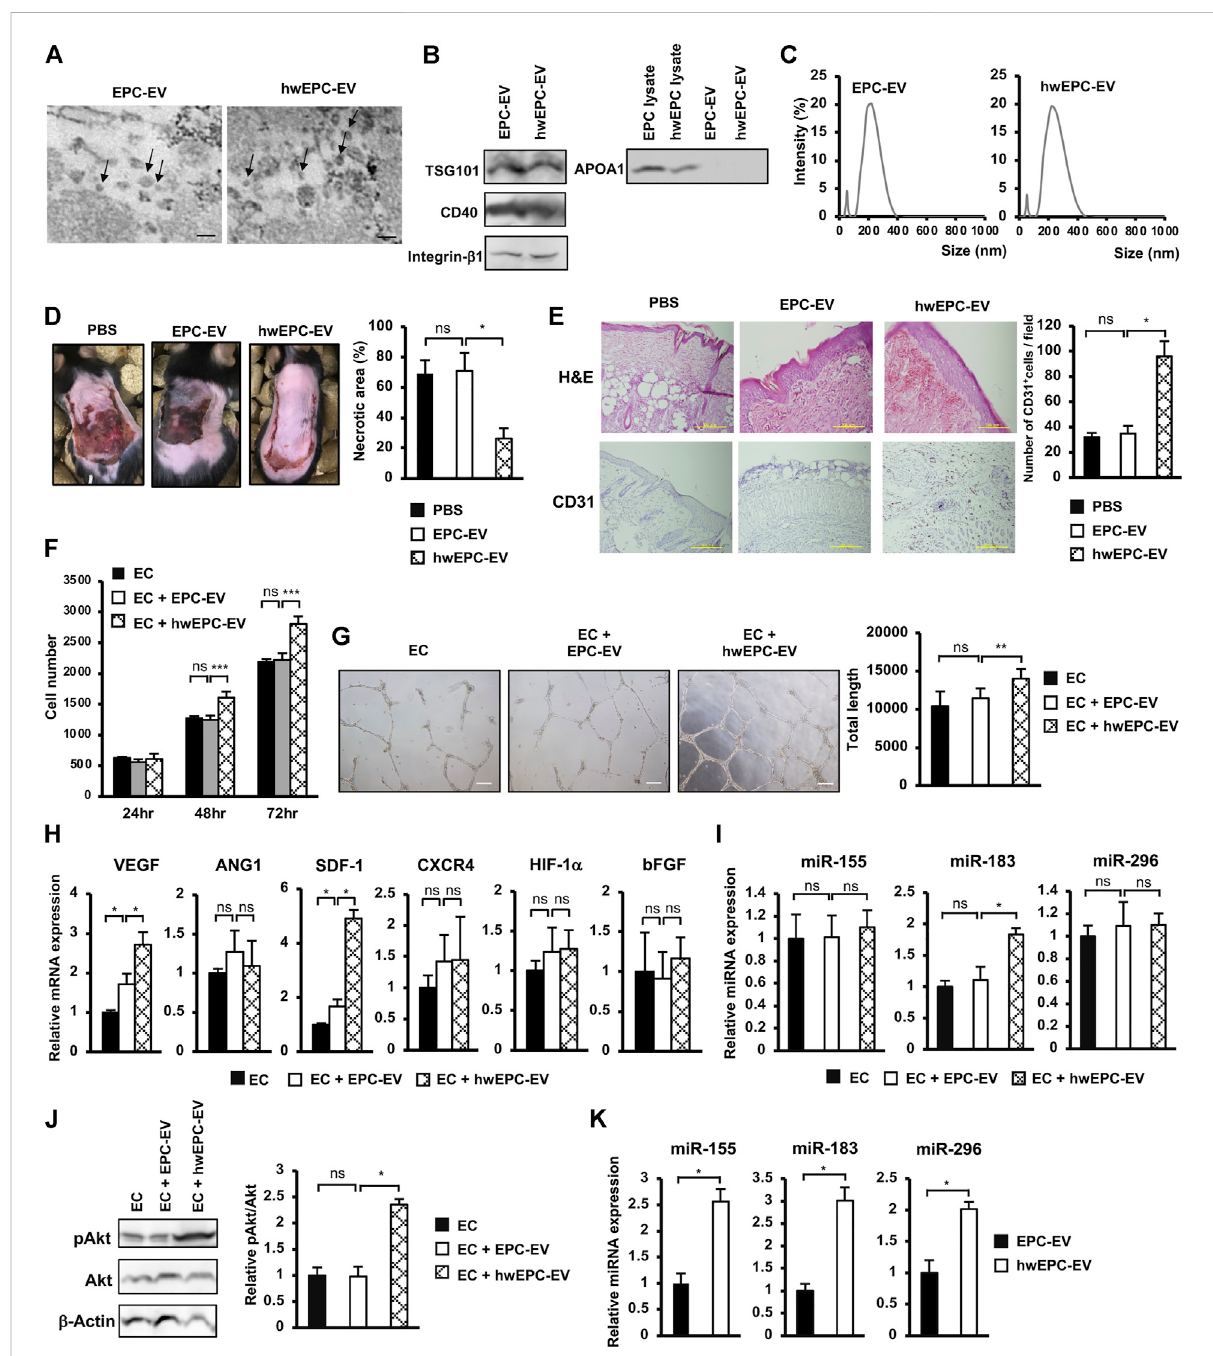
FIGURE 3 hwEPC secreted a high functional EV which induced the proliferation and angiogenic functions of endothelial cells (EC) in neovascularization (A) . Morphology of EPC-EV and hwEPC-EV under a transmission electron microscope. Bars indicate 200 nm (B) . Markers expression of EPC-EV and hwEPC-EV. Full-length Western blots are shown in Supplementary Figure S6 (C) . Size distribution of EPC-EV and hwEPC-EV. The experiments were performed in triplicate (D) . The necrotic area of ischemic fl ap model mice with local injection ( n = 9) (E) . Immunohistochemical staining of CD31inskintissuespecimensfromlocallyinjectedmice.Thephotoswerecapturedunderamicroscopeat10×magni fi cation.Barsindicate500 µm (F) . The cell proliferation of HUVEC ( n = 3) (G) . Representative imaging and total length of HUVEC tube formation ( n = 3). The photos were captured under a microscope at 4 × magni fi cation. Bars indicate 200 µm (H) . The gene expression of HUVEC ( n = 3) (I) . The miRNAs expression of HUVEC, normalized with RNU48 ( n = 3) (J) . The phosphorylation of Akt in HUVEC was examined by Western Blotting. Full-length Western blots are shown in Supplementary Figure S6 ( n = 3) (K) . The miRNAs expression in EPC-EV and hwEPC-EV, normalized with RNU48 ( n = 3). Data represent the mean ± SD. ** p < 0.01, * p < 0.05, ns: no signi fi cance. The experiments were performed in triplicate.